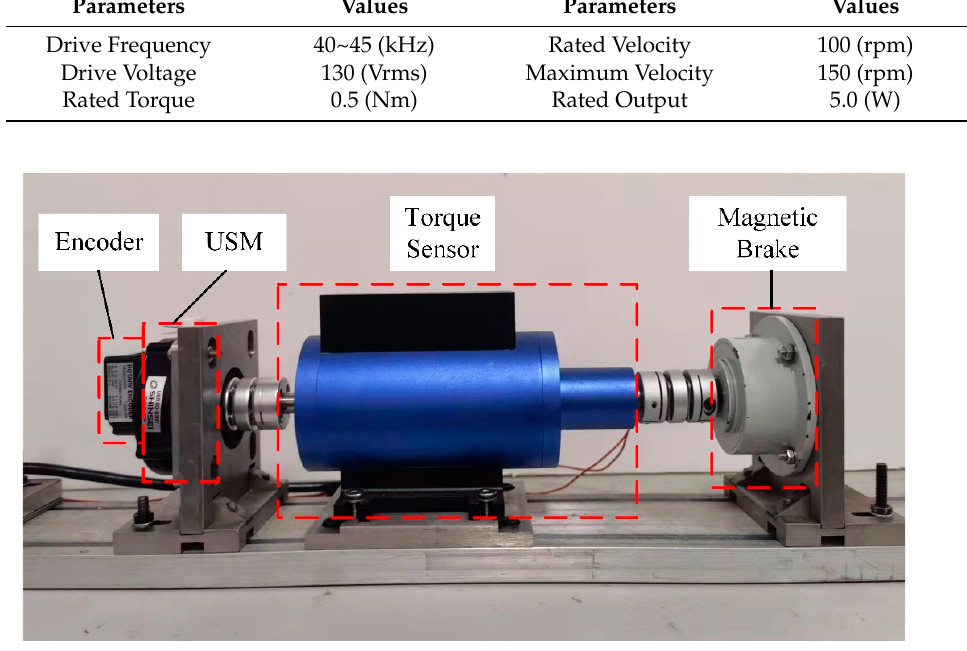
Figure 8. Experimental setup for TRUSM.